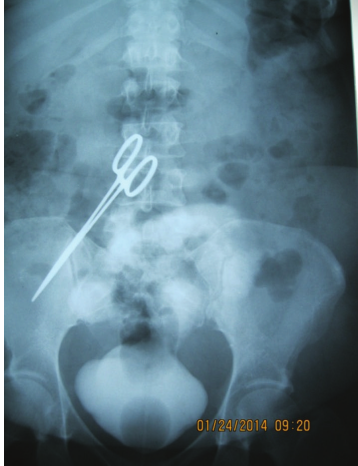
Figure 2: Cystogram showing contrast extravasation into the abdomen and a pair of artery forceps lying in abdominopelvic